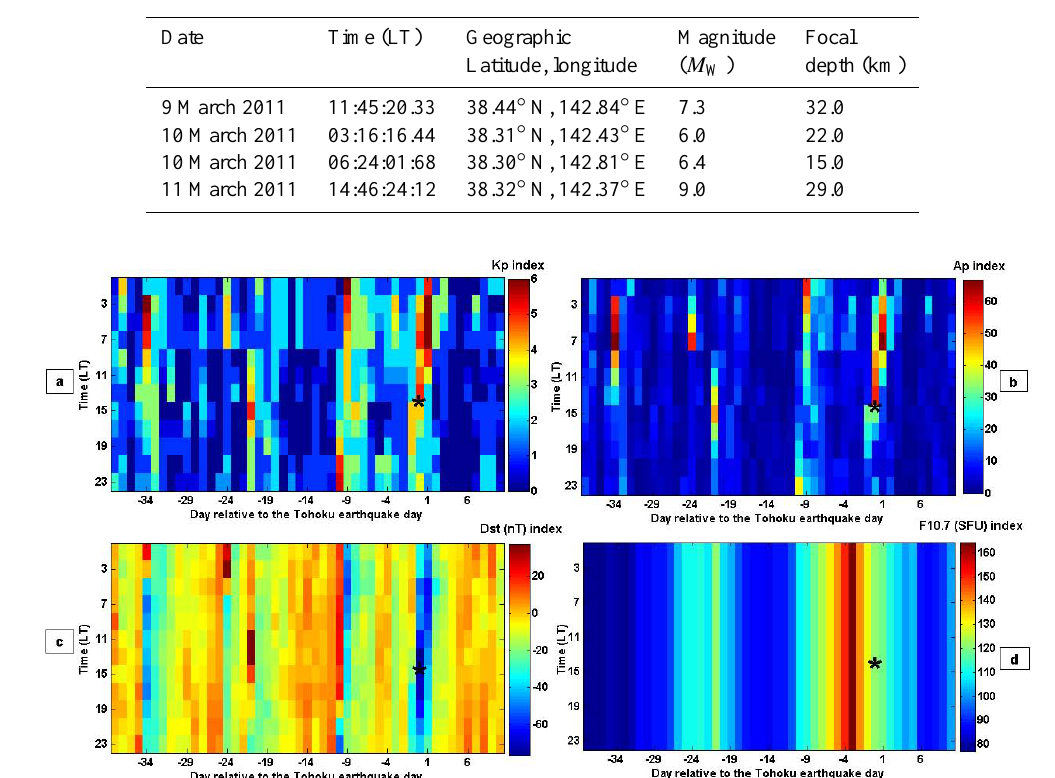
Fig. 1. Data of geomagnetic indices during the period of 1 February to 21 March 2011 showing variations of (a) K p , (b) A p , (c) D st and (d) F 10 . 7. A black asterisk indicates the earthquake time. The X-axis represents the days relative to the earthquake day. The Y-axis represents the local